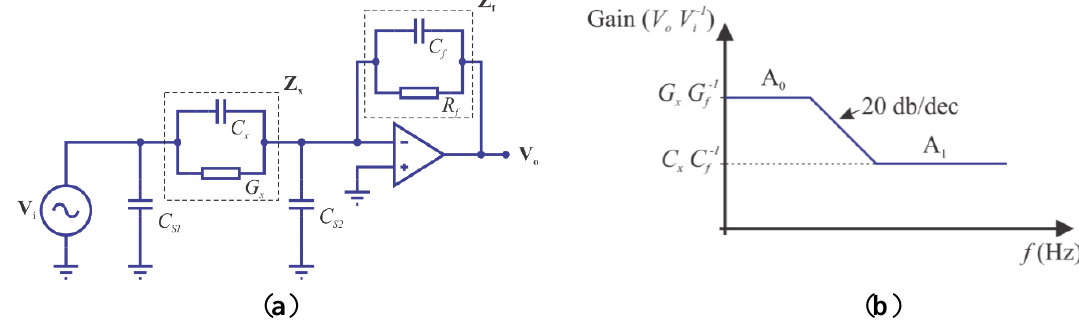
Figure 2. ( a ) Auto-balancing bridge circuit and frequency domanin response ( b